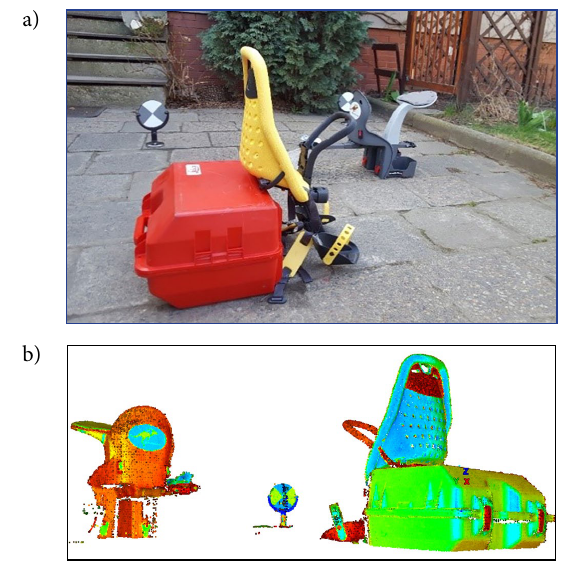
Figure 2. 3D laser scanning: a – two various designs of front- mounted baby carriers; b – reflectivity colour spectrum applied onto cloud of